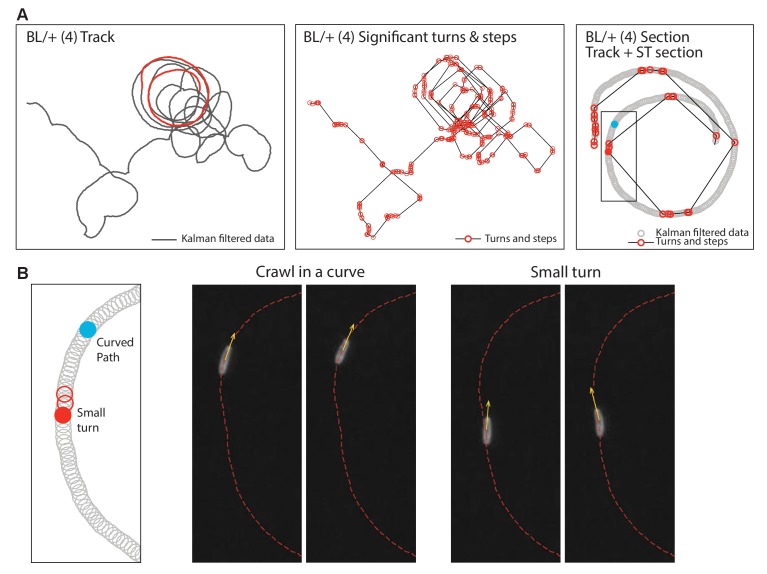
Analysis of curved paths.Drosophila larva sometimes exhibit curved paths within movement trajectories. (A) This shows an example of a Kalman filtered track of a control larva (BL/+ at 33°C) executing a curved path. The section highlighted in red is shown in more detail in the third panel. The second panel shows the significant turns and steps for the same animal as determined using the objective move-step estimating method (Humphries et al., 2013; Tromer et al., 2015) (see Materials and methods). Without more detailed analysis, the path as plotted in is panel implies that the method identifies small steps where they appear not to occur. However, a detailed analysis of a panel 3 section is shown in (B). This demonstrates that curved tracks are indeed generated by larvae crawling in a curve (a consistent but minor deviation in heading), but that small turns do interrupt the curve and are correctly identified by the objective move-step estimation method used.